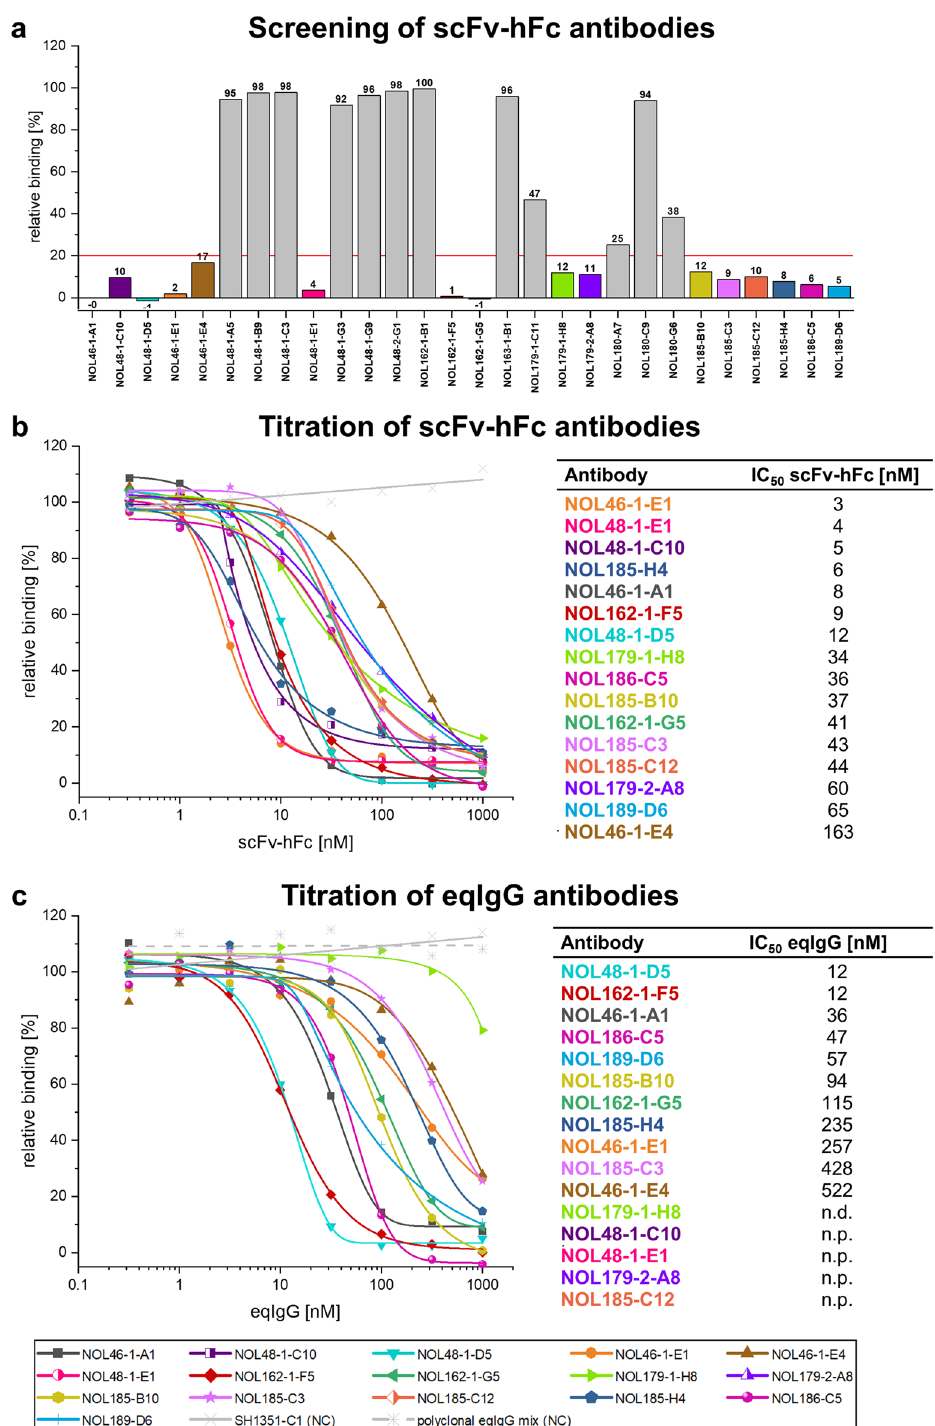
Figure 1. Cellular inhibition assay. ( a ) Screening inhibition assay with 28 scFv-hFc antibodies against eqIL-5 on receptor positive cells using 1000 nM antibody and 5 nM interleukin (related to dimer) (molar ratio 200:1). The cut-off for the selection of inhibiting antibodies is marked with a red line and antibodies for further analysis are marked in colors. ( b,c ) Titration inhibition assay with antibodies in ( b ) scFv-hFc format and ( c ) eqIgG6 format using 1000 nM–0.32 nM antibody and 5 nM antigen (related to dimer) (molar ratio 200:1–0.064:1). IC 50 values were determined with OriginPro using the Logistic5 Fit. For the isotype control a linear fit was applied. Screening and titration assays were performed in single measurements (n = 1). n.p. not producible, n.d. not